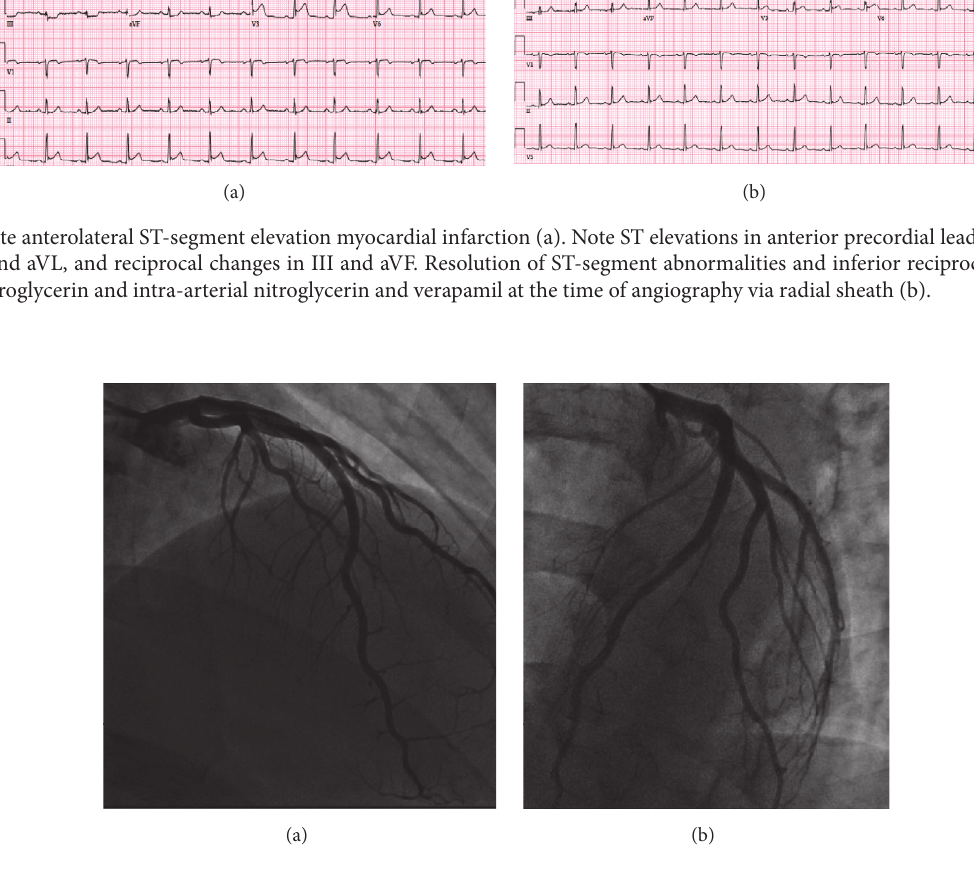
Figure 2: Straight AP cranial (a) and left anterior oblique cranial (b) projections of normal left anterior descending coronary